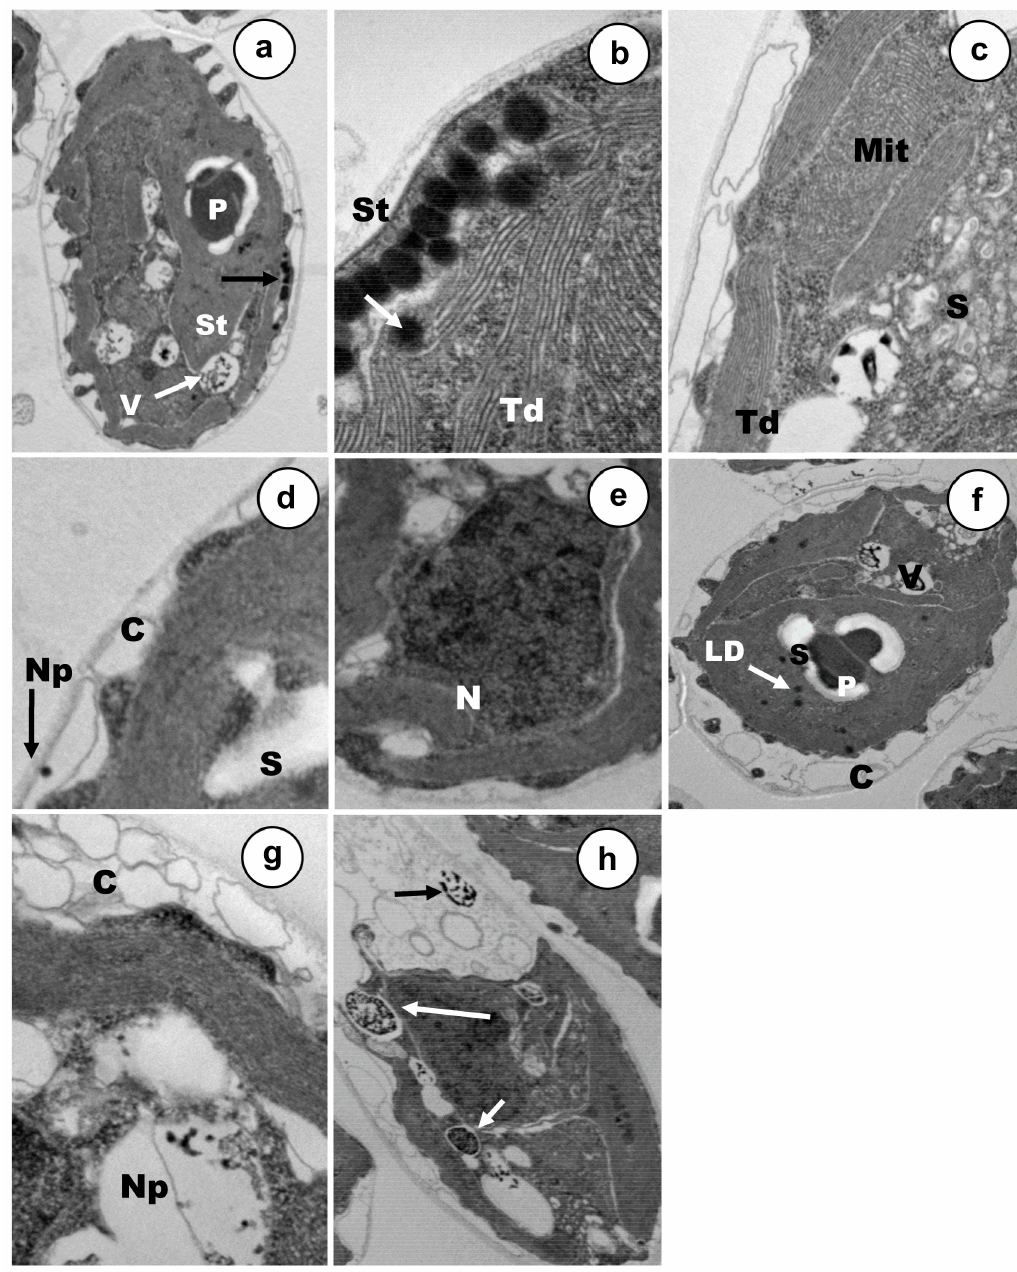
Figure 5. TEM micrographs of arsenite treated cells. ( a ) View of a vegetative cell in longitudinal section; (12k × ), ( b ) Severe disorganization of photoreceptive stigma (60k × ). ( c ) Starch deposits, mitochondria, and alterations in thylakoid membranes (40k × ), ( d ) Nanoparticles-like embedded in the polysaccharidic capsule, (60k × ). ( e ) Altered nuclear pattern (60k × ). ( f ) Vegetative cell showing lipid droplets, bioaccumulation, starch deposits, and exopolymer discharge (12k × ). ( g ) Cytoplasmic nanoparticles-like into vacuoles (40k × ). ( h ) Full vacuoles expelled outside cell (12k × ). S—Starch deposits; P—pyrenoid; St—stigma; V—vacuole; Td—thylakoids; C—capsule; Np—nanoparticles-like; Mit—mitochondria; CW—cell wall;